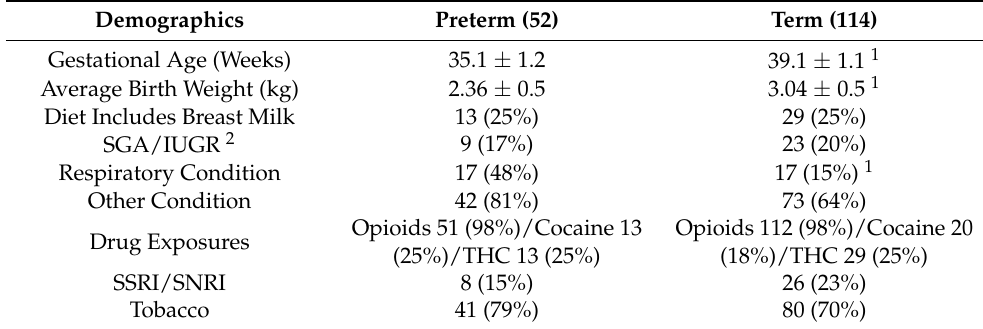
Table 1. Maternal and Infant